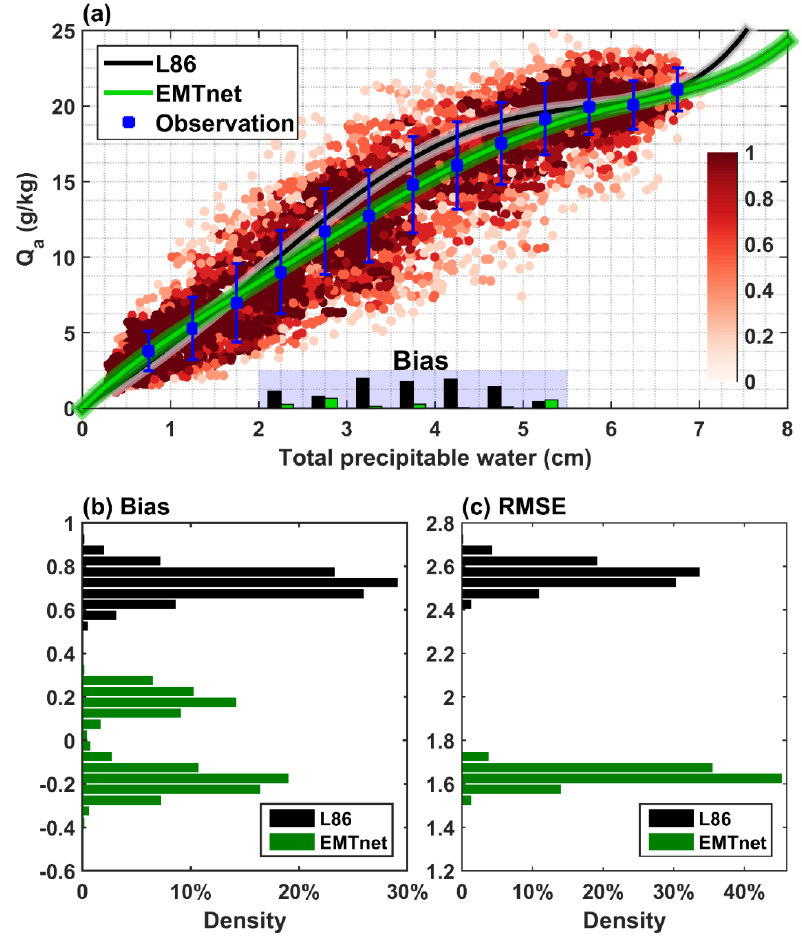
Figure 5. Comparisons of the EMTnet model and the L86 model. ( a ) The scatter diagram of Q a (ordinate) and TPW (abscissa), while the bars show the model biases. In ( a ), the red dot denotes the data density in each 0.5 cm bin of TPW and 0.5 g/kg bin of Q a with units of ‰. The blue square and error bar are the median and one STD of Q a observations in each 0.5 cm bin of TPW. ( b , c ) The PDDs of the mean bias and RMSE in 1000 sets of DNN computations. Black and green lines and bars are the results of the L86 model and the EMTnet model. The units of mean bias and RMSE are g/kg. Figure 5b,c depict the PDDs of the mean biases and RMSEs of the EMTnet model and the L86 model according to the 1000 samples of testing data used in the EMTnet